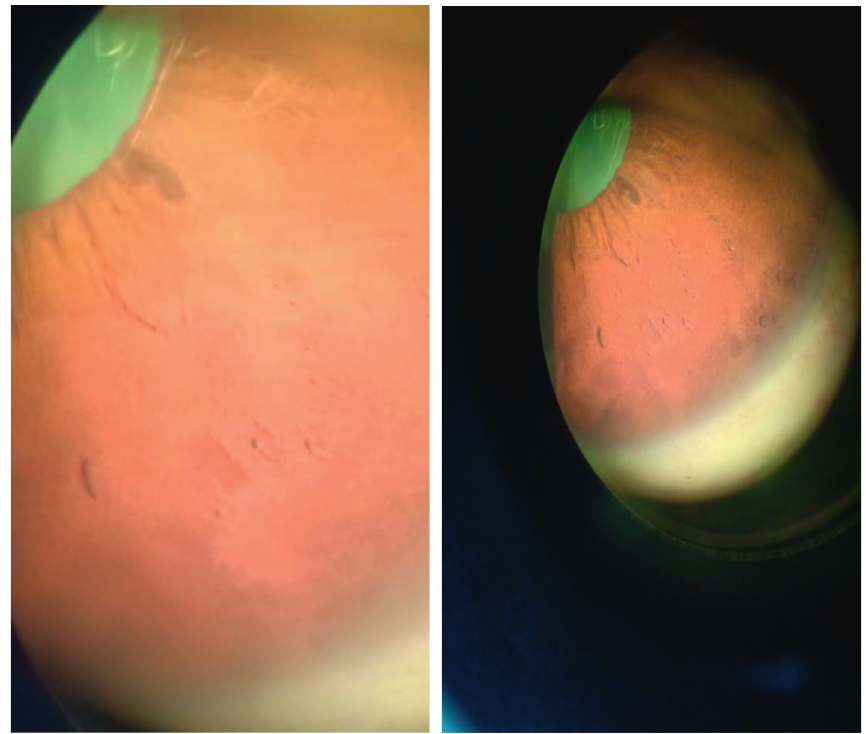
Figure 4: Lisch nodules without clinical visual involvement on ophthalmologic